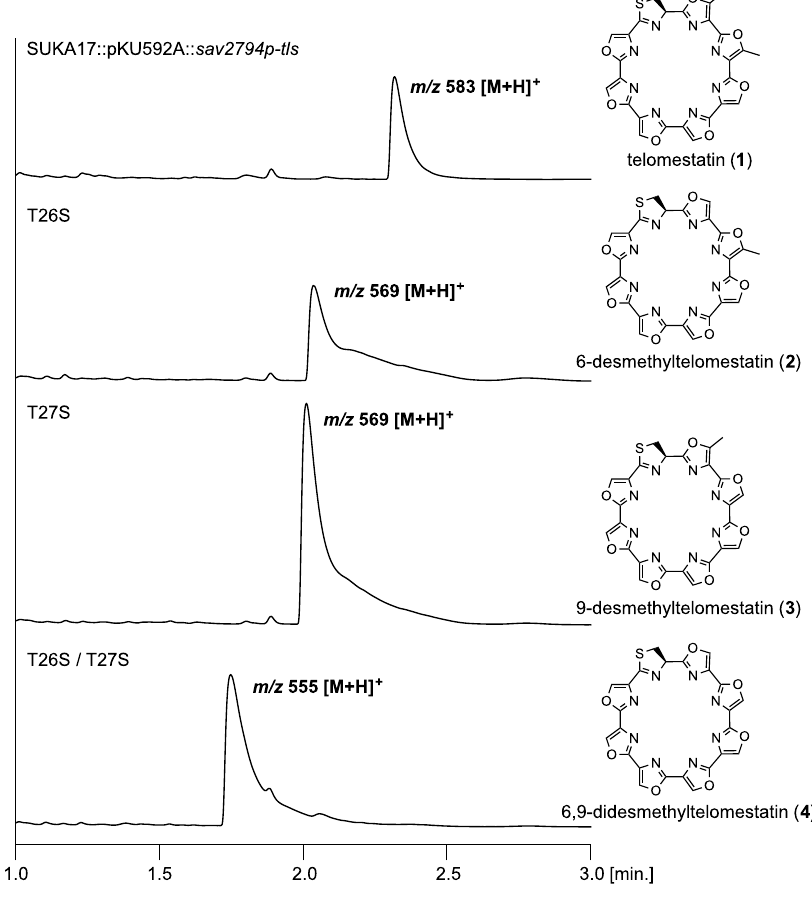
Figure 5. HPLC/MS analysis of metabolites produced in SUKA17, which was transformed with the tls gene cluster containing a mutation in tlsC